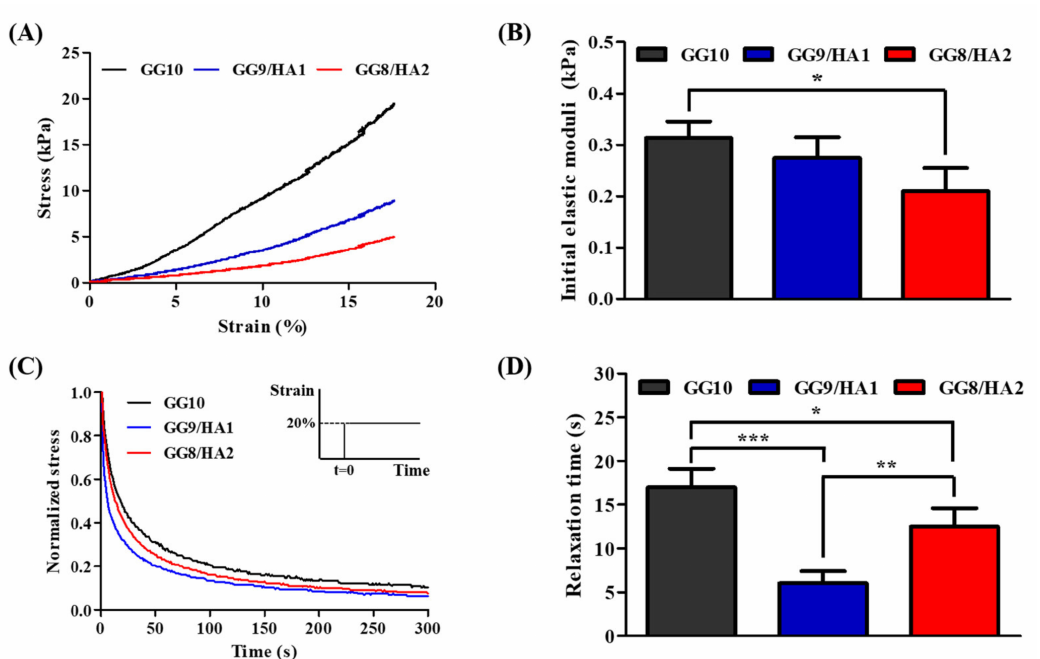
Figure 3. Mechanical characterization of the hydrogels. ( A ) Stress–strain curve of the hydrogels analyzed at a speed of 1 mm/min with a load cell of 10 N; ( B ) initial elastic modulus at 5–10% strain; ( C ) stress relaxation analysis under constant strain; ( D ) normalized relaxation time (values are mean ± SD ( n = 4), p < 0.05 (*), p < 0.01 (**), and p < 0.001